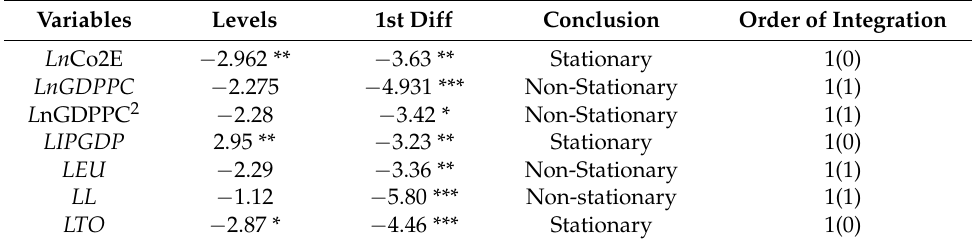
Table 1. ADF Unit root test results.